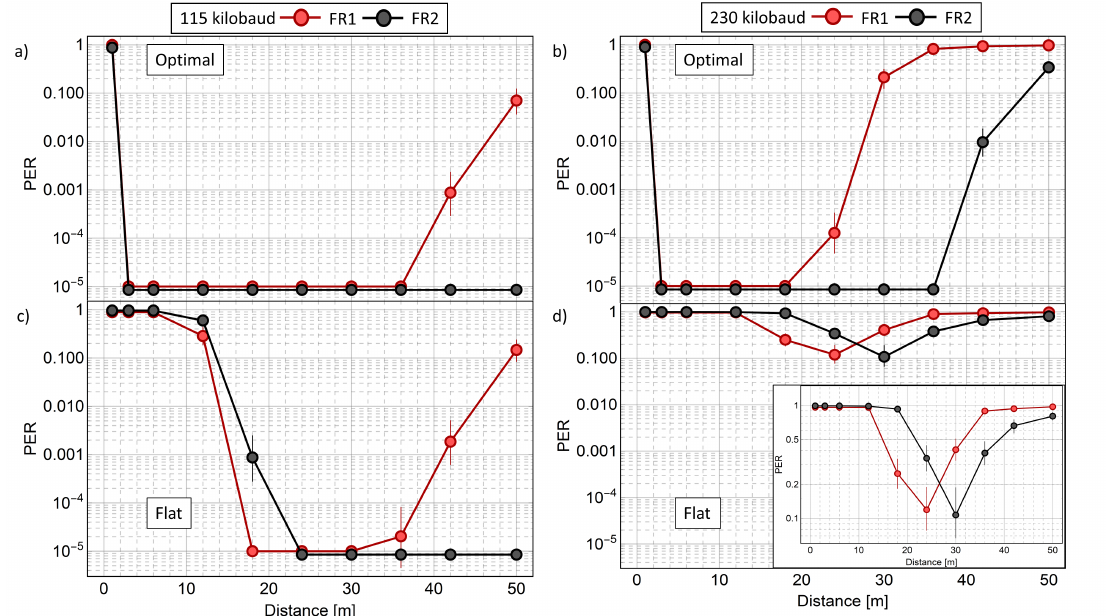
Figure 4. PER vs Distance. Two baud rates of 115 kbaud (left panel) and 230 kbaud (right panel) are used for data transmission. The sub-figures ( a , b ) show the Optimal configuration for two Fresnel lenses FR 1 and FR 2, while ( c , d ) represent the Flat configuration. The inset in ( d ) reports data on a zoomed vertical